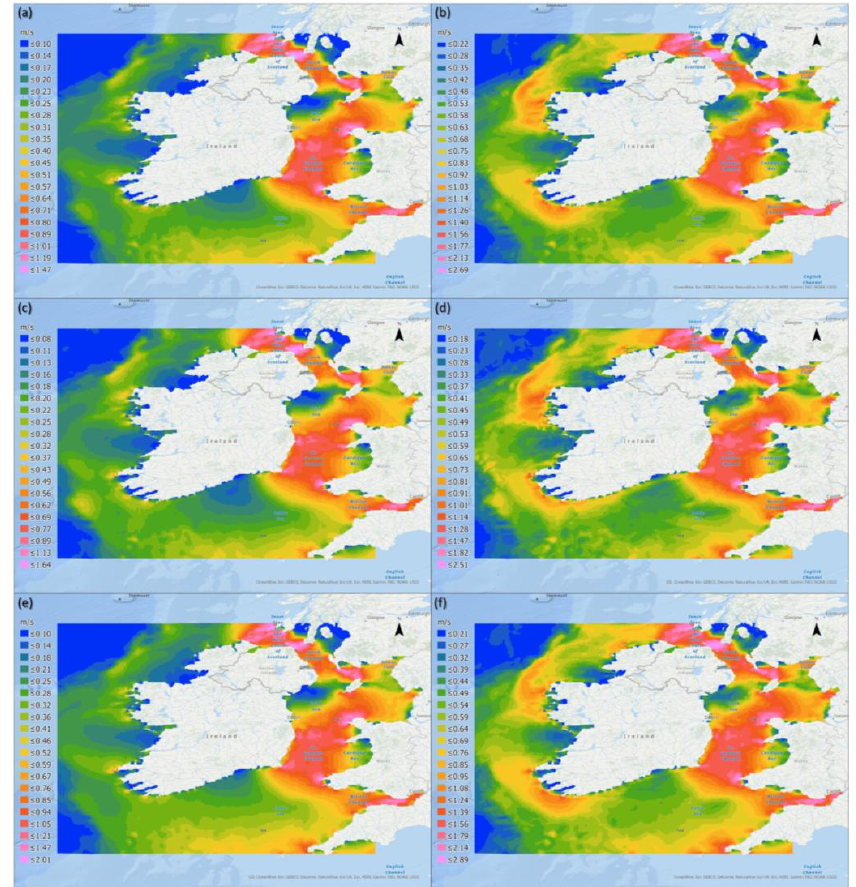
Figure A3. The values in metres per second for ( a ) the mean peak current velocity, ( b ) the maximum peak current velocity, ( c ) the mean peak current velocity on neap tides, ( d ) the maximum peak current velocity on neap tides, ( e ) the mean peak current velocity on spring tides and ( f ) the maximum peak current velocity on spring tides.